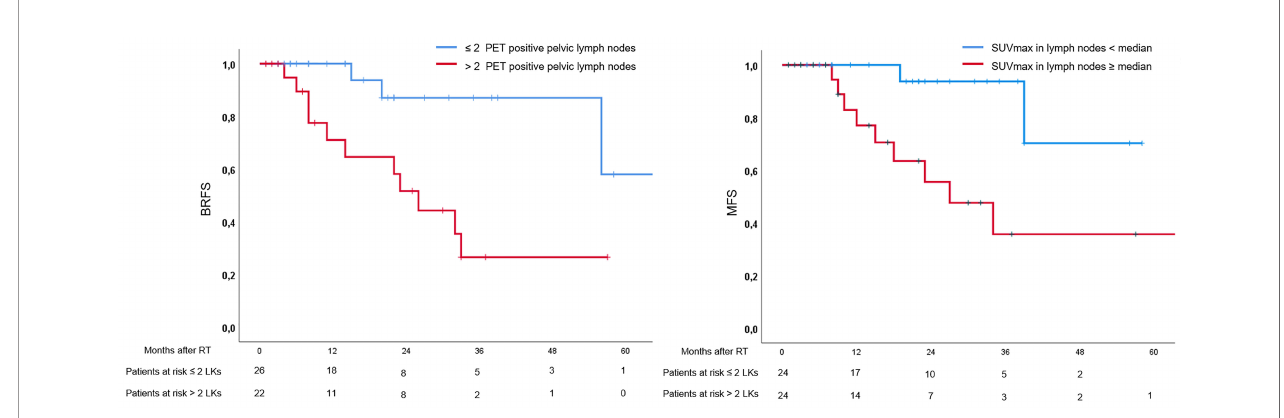
FIGURE 1 | Kaplan – Meier curves. Left: Curves for biochemical recurrence-free survival in patients with > and ≤ 2 positive lymph nodes in positron emission tomography (PET). Right: Curves for metastasis-free survival (MFS) in patients with maximal standardized uptake values (SUVmax) ≥ and <